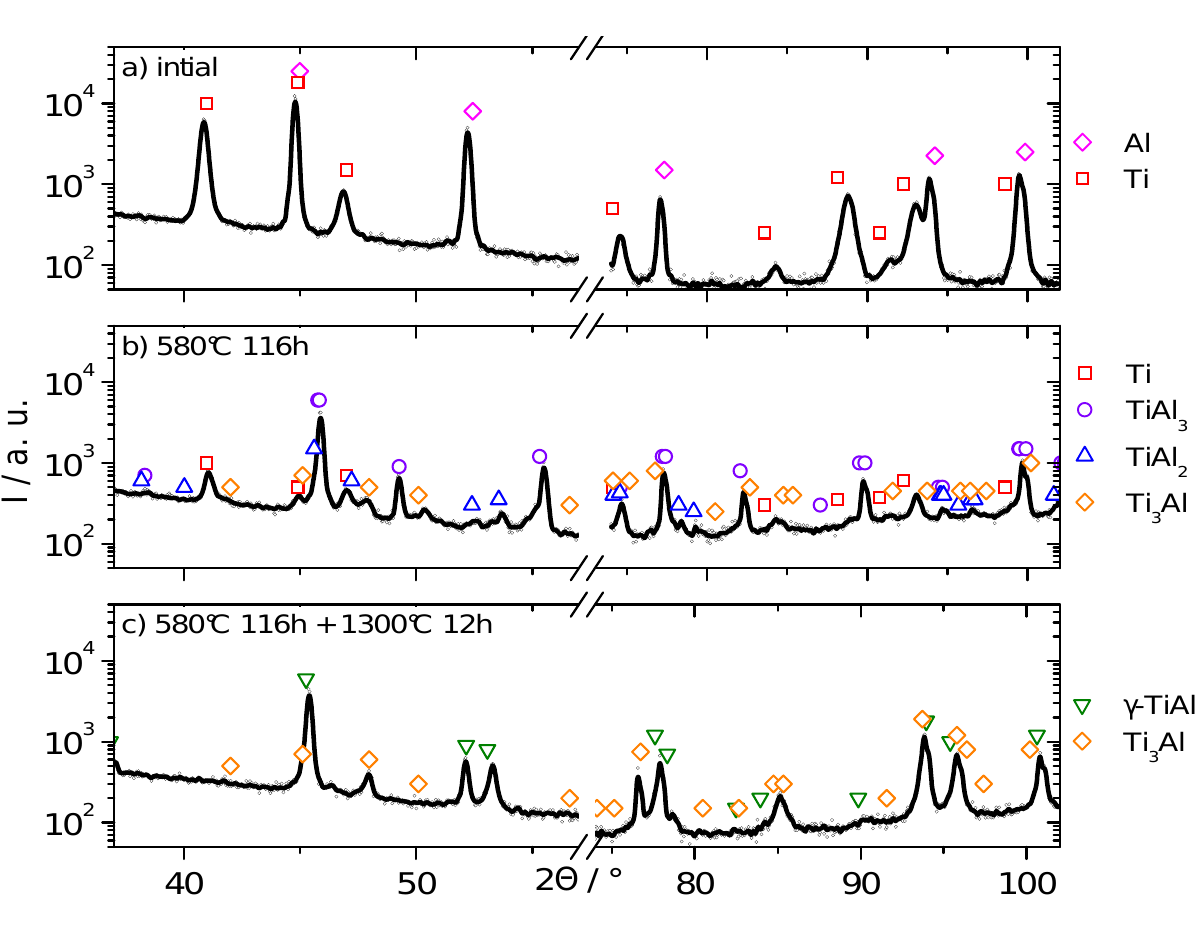
Figure 4. X-ray diffractograms of ( a ) the initial wire; ( b ) after 116 h at 580 °C and ( c ) additionally annealed for 12 h at 1300 °C.